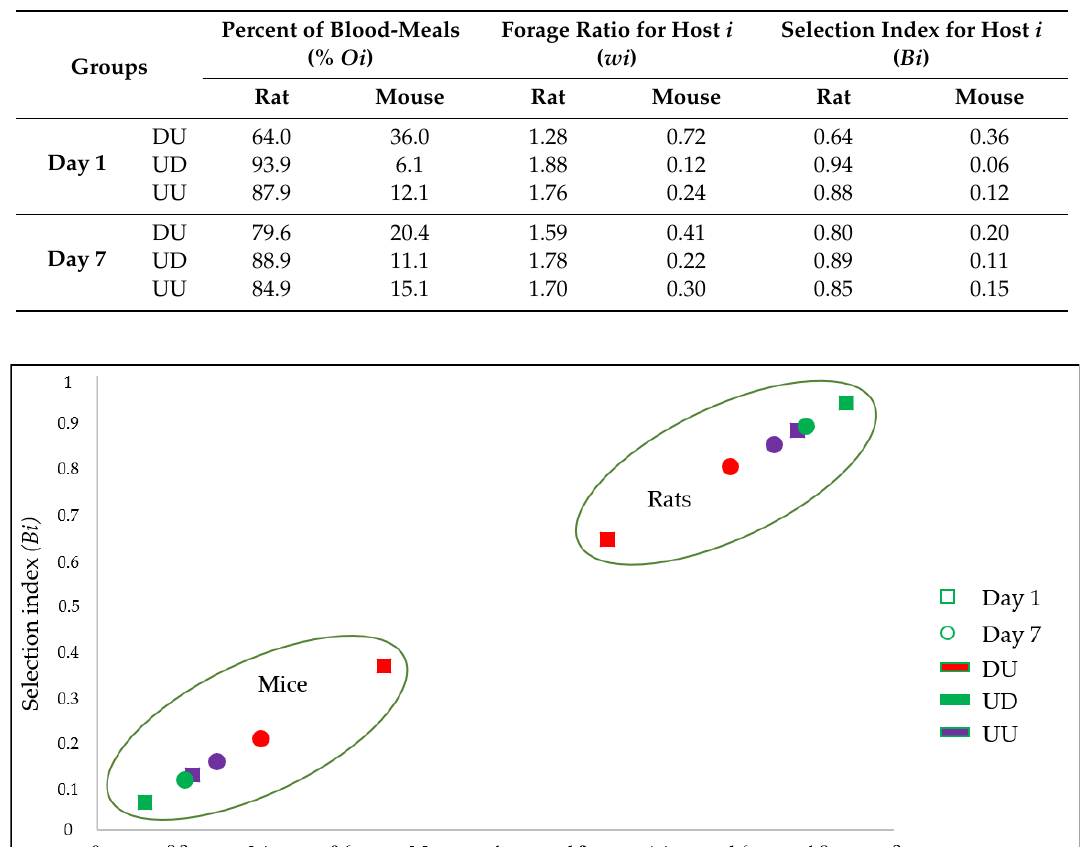
Table 5. Feeding preference of Ae. albopictus in each group towards treated / untreated hosts expressed by forage ratio and selection index.